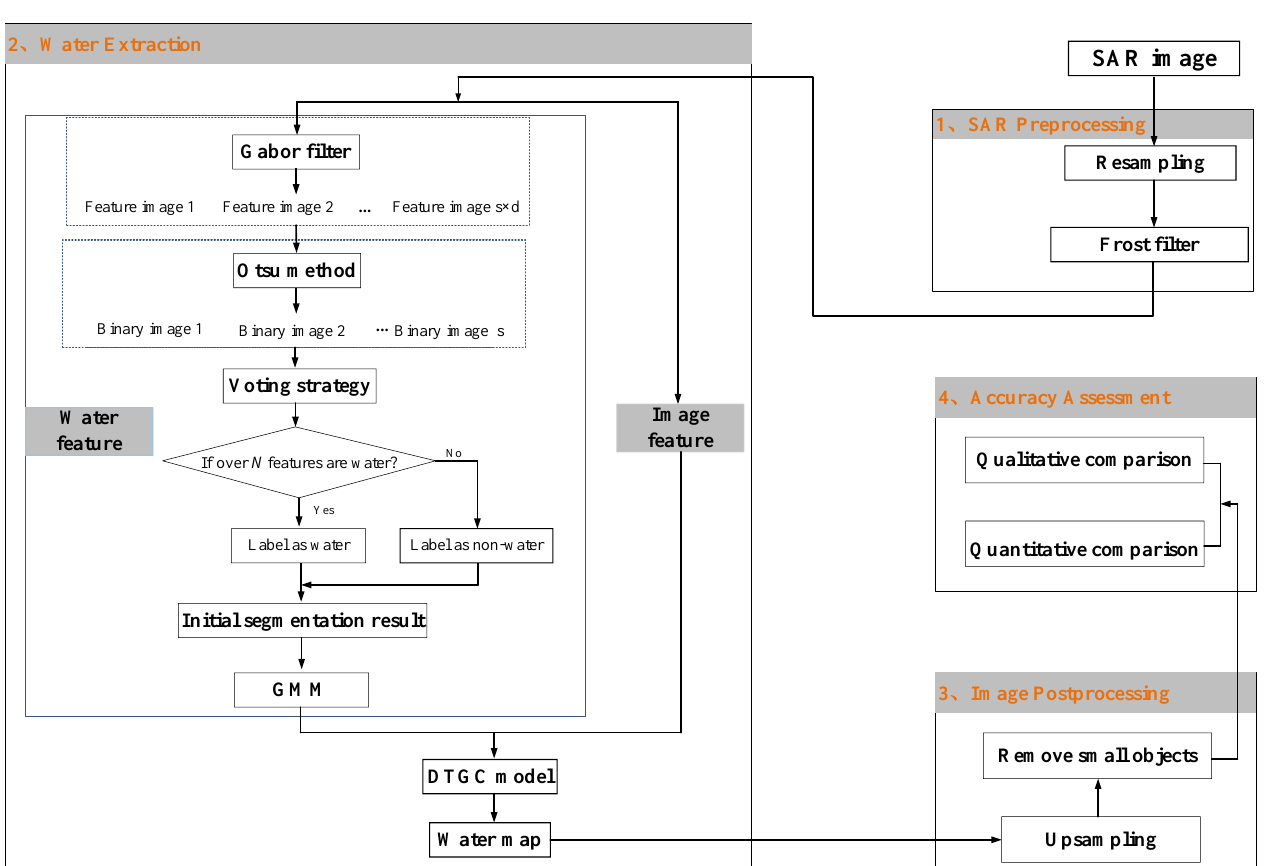
Figure 1. The overview of this study. The parameters s and d are the number of scales and directions of Gabor filter. The parameter N is a feature threshold of voting strategy.